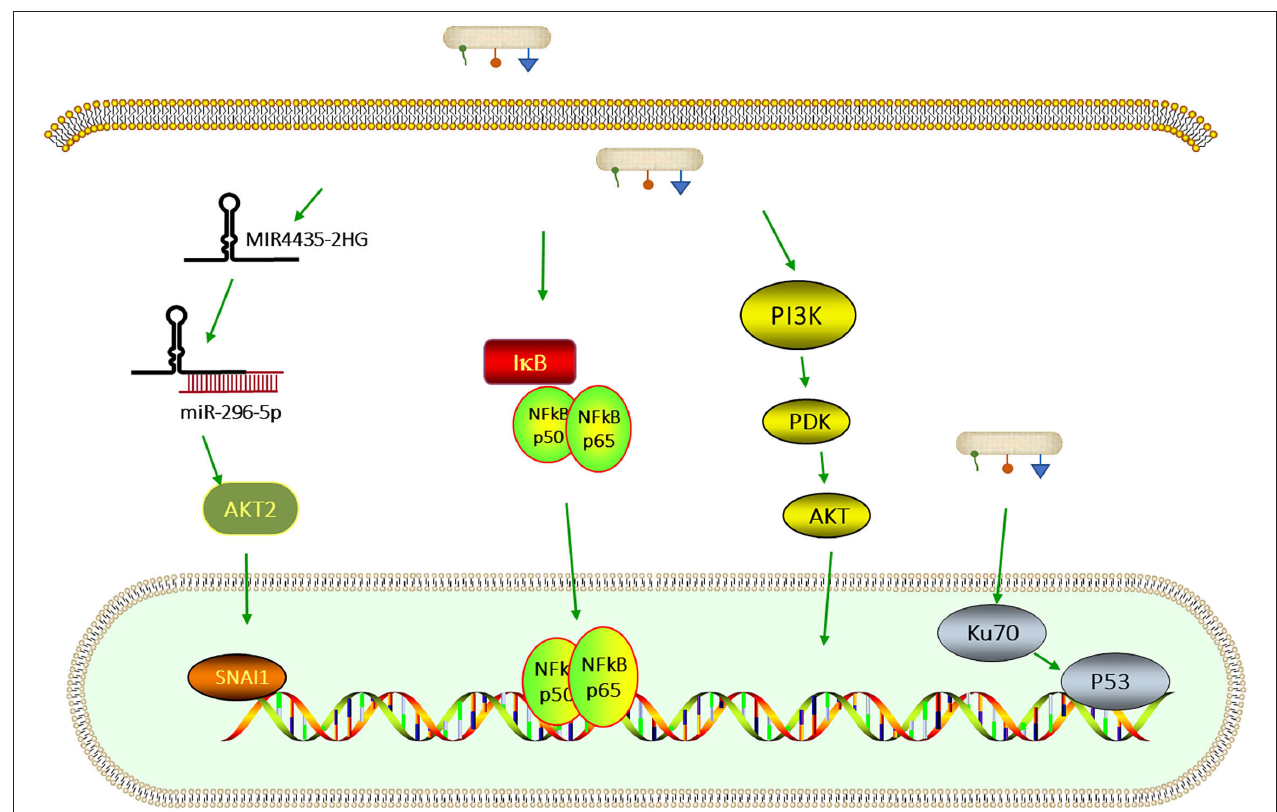
FIGURE 2 | Signaling pathways that are related to F. nucleatum infection. F. nucleatum upregulates MIR4435-2HG, which binds miR-296-5p and weakens the inhibitory effect of miR-296-5p on SNAI1 via AKT2 [77]. F. nucleatum can also activate the PI3K/AKT—nuclear factor kappa B (NF- κ B) signaling pathway which regulates cell proliferation, apoptosis, and the inflammatory response [72]. The infection with F. nucleatum promotes the capability of proliferation by leading to DNA damage through the Ku70/p53 pathway [78].